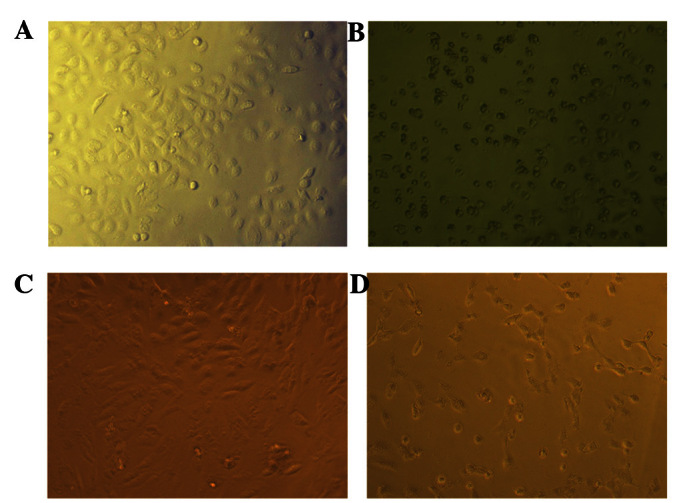
Morphology of GES-1 and SGC-7901 cells treated with 1,200 μmol/l canolol.